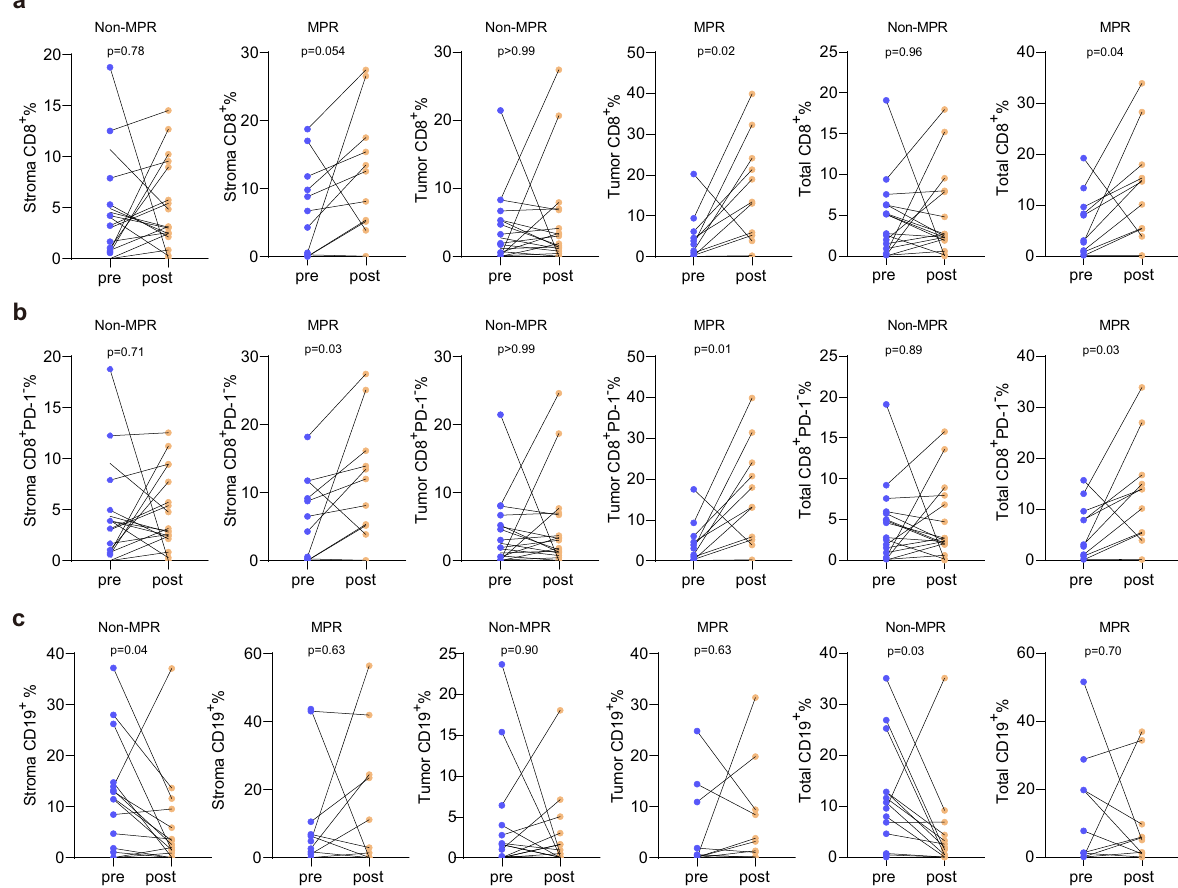
Fig. 5 The change of CD8 + and CD19 + cells was distinct in MPR and Non-MPR patients. a Analysis of changes in CD8 + T cells in fi ltration in MPR and Non-MPR patients (Mann – Whitney U test for paired samples). b Analysis of changes in CD8 + PD-1 − T cells in fi ltration in MPR and Non-MPR patients (Mann – Whitney U test for paired samples). c Analysis of changes in CD19 + cells in fi ltration in MPR and Non-MPR patients (Mann – Whitney U test for paired